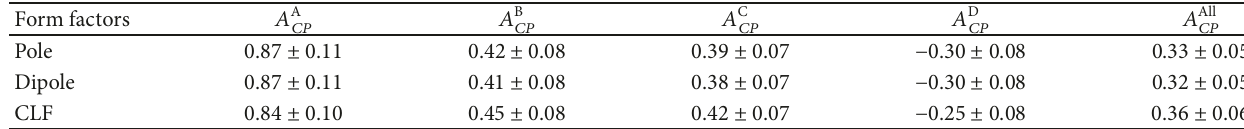
Table 4: Three from factor models: the pole, dipole, and CLF models are used for the regional 𝐶𝑃 asymmetries (in unit of 10 −4 ) in the four areas, A, B, C, and D, of the phase space.